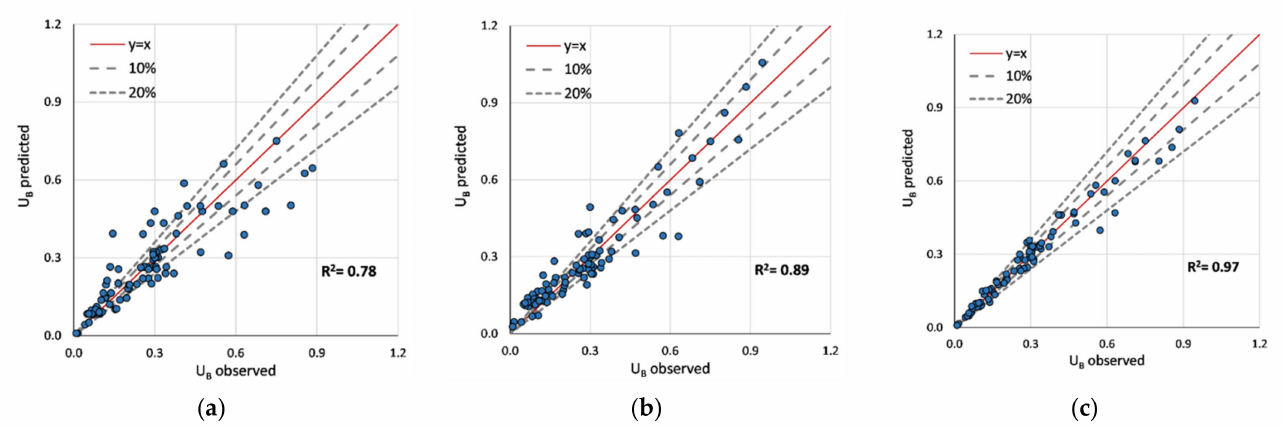
Figure 5. Comparison of validation accuracies of predicted f S : ( a ) decision tree regressor; ( b ) extra tree regressor; ( c ) XGBoost regressor; ( d ) Shi et al. [4].